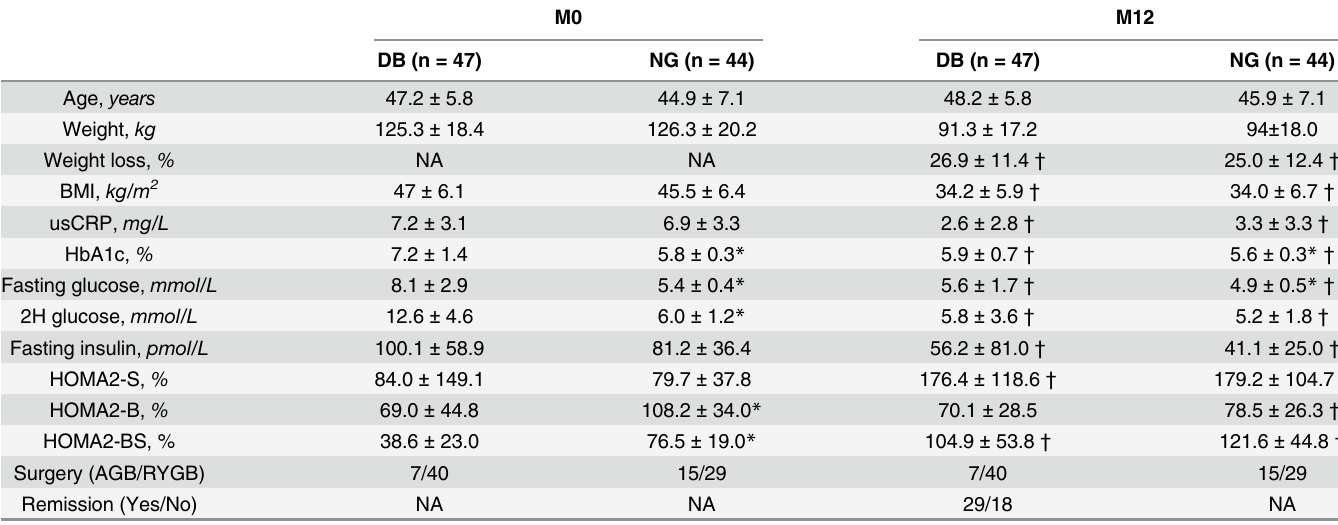
Table 1. Clinical characteristics of diabetic (DB) or normoglycemic (NG) women with obesity from the ABOS cohort at inclusion (M0) and 12 months after surgery